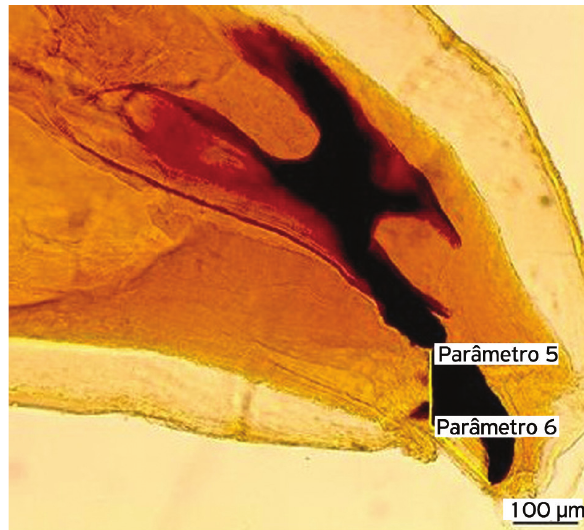
Figura 3. Parâmetros utilizados na morfometria das estruturas anteriores e posteriores das larvas de Neosilba perezi: 5. Altura da base da mandíbula em vista lateral; 6. Comprimento angular da mandíbula em vista lateral.